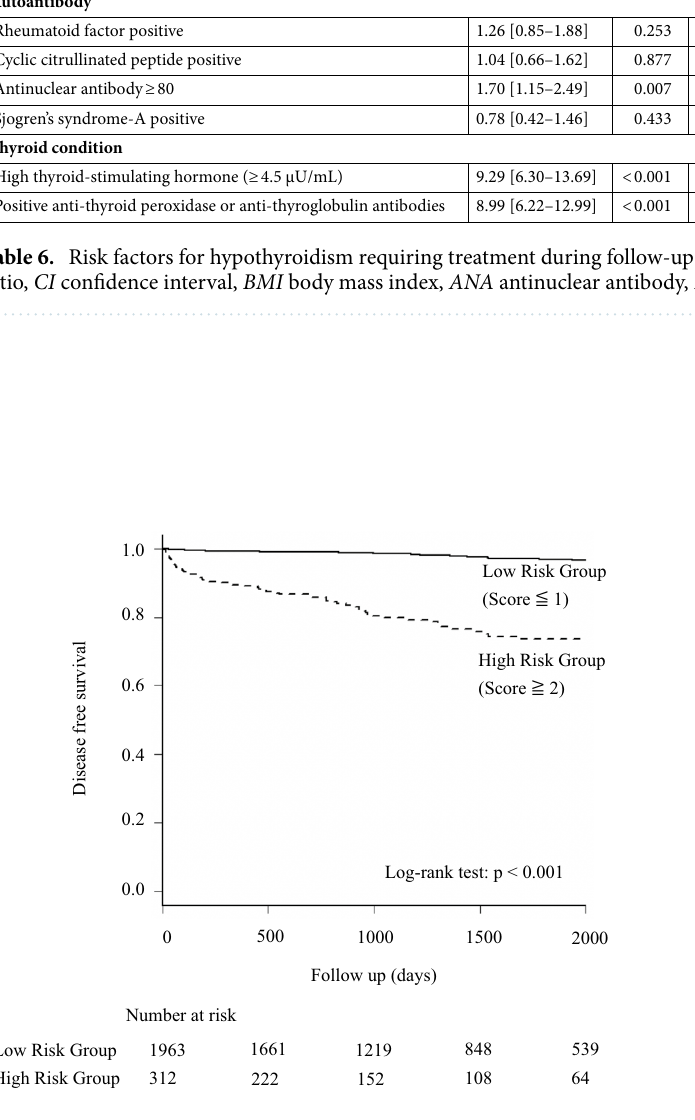
Figure 2. Disease-free survival of newly detected hypothyroidism requiring treatment in high-risk or low-risk patients with autoimmune rheumatic